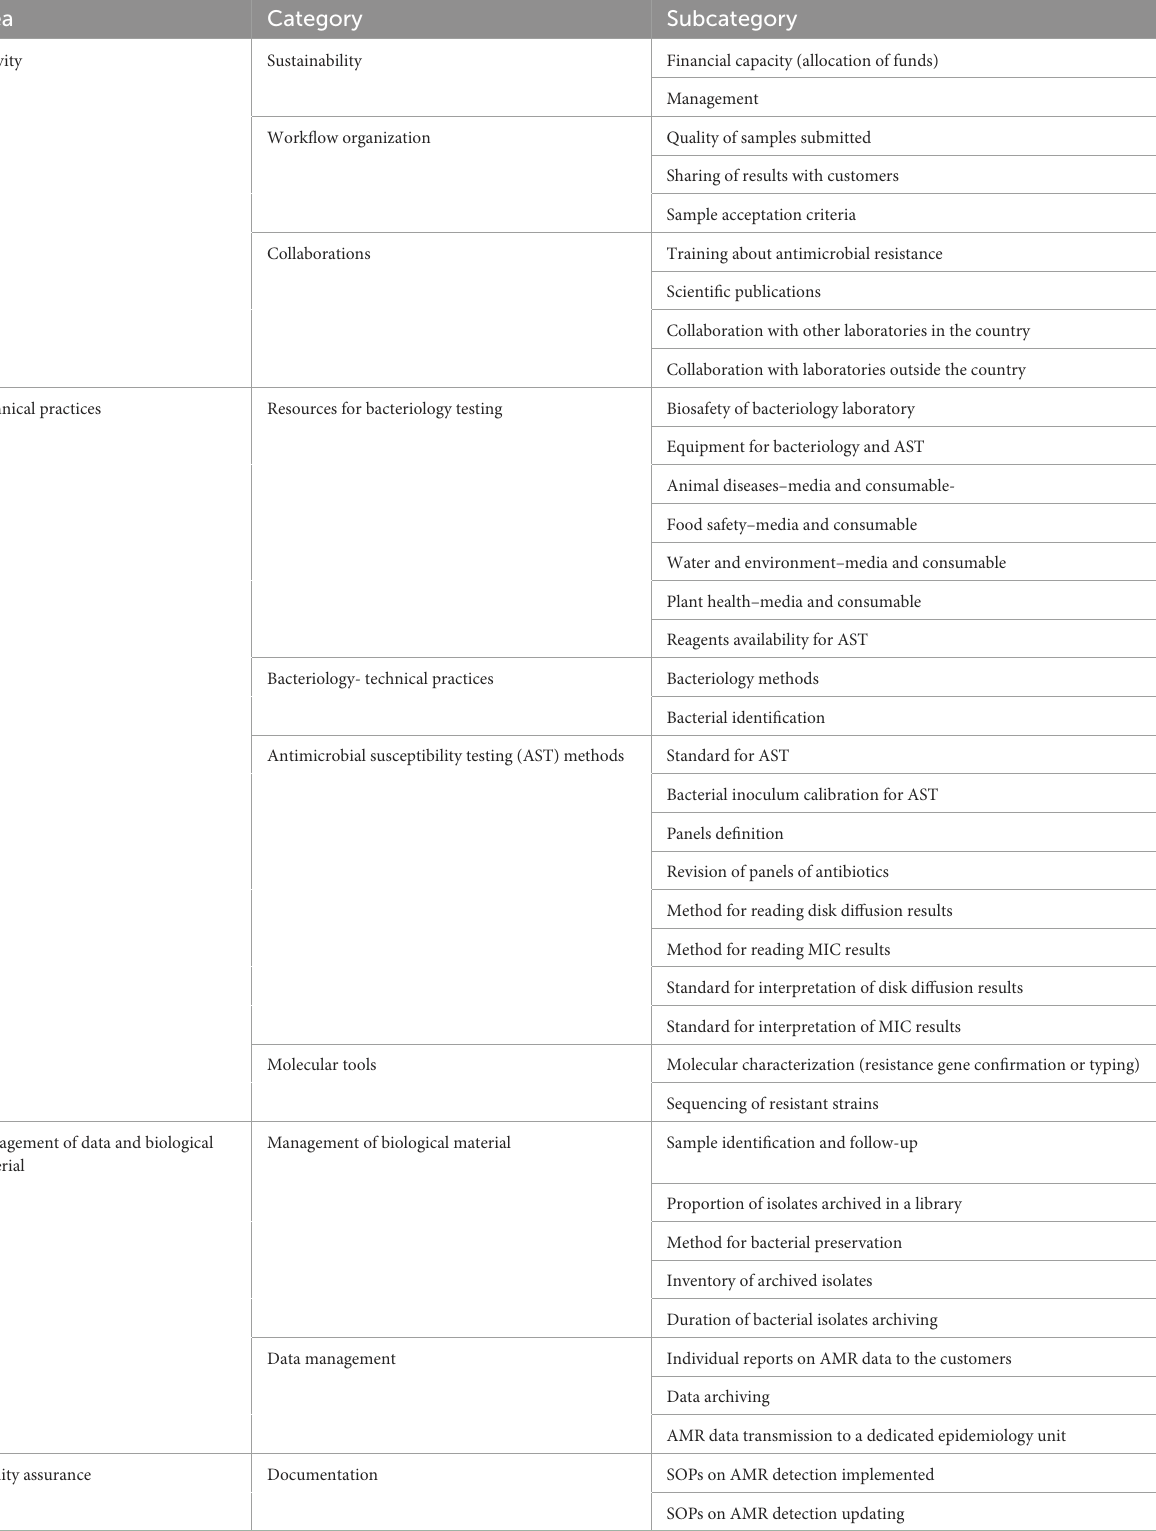
TABLE 2 Information collected in FAO-ATLASS LMT-AMR